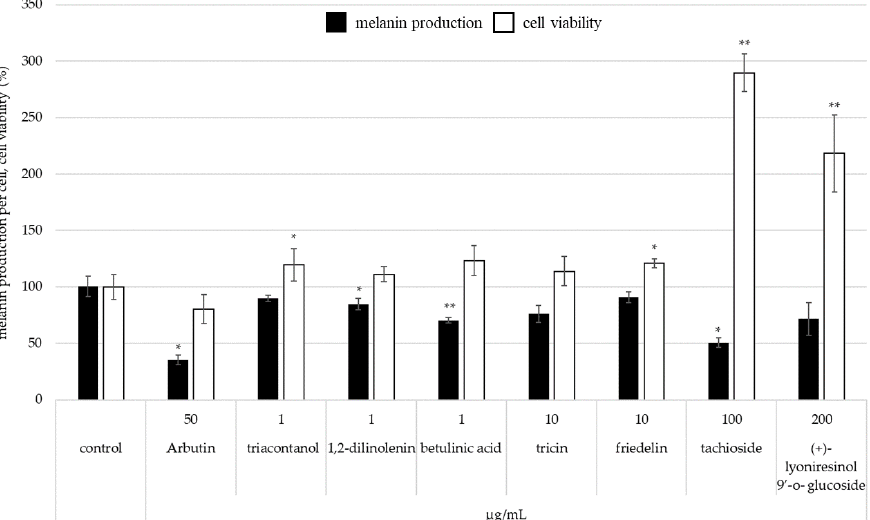
Figure 5. Chemical structures of compounds 1–12, isolated from peels of P. pubescens. 2.4. Effects of Bamboo Isolated Compounds on Production of Melanin, Hyaluronic Acid, and Collagen To estimate the function of isolated compounds from P. pubescens peel against human skin, we examined the effect of isolated compounds from P. pubescens peel on production of melanin, hyaluronic acid, and collagen.